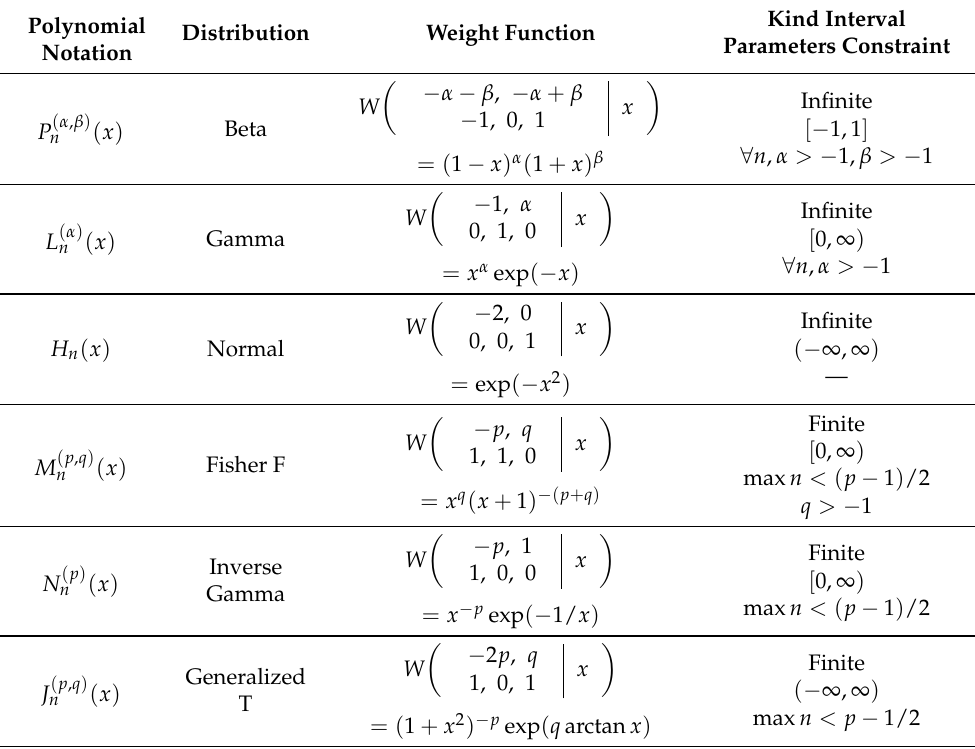
Table 1. Characteristics of six sequences of classical orthogonal